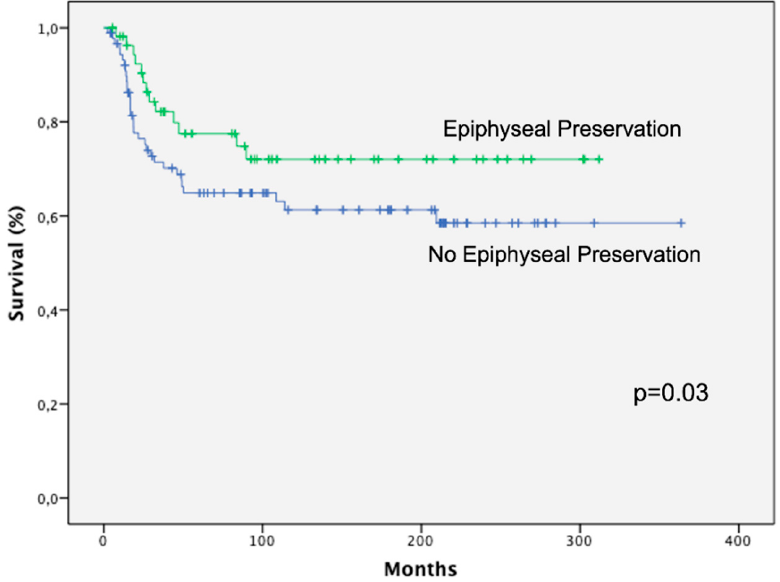
Figure 7. Kaplan–Meier analysis showing that patients treated with epiphyseal preservation had a significantly better overall survival rate than patients treated without physis